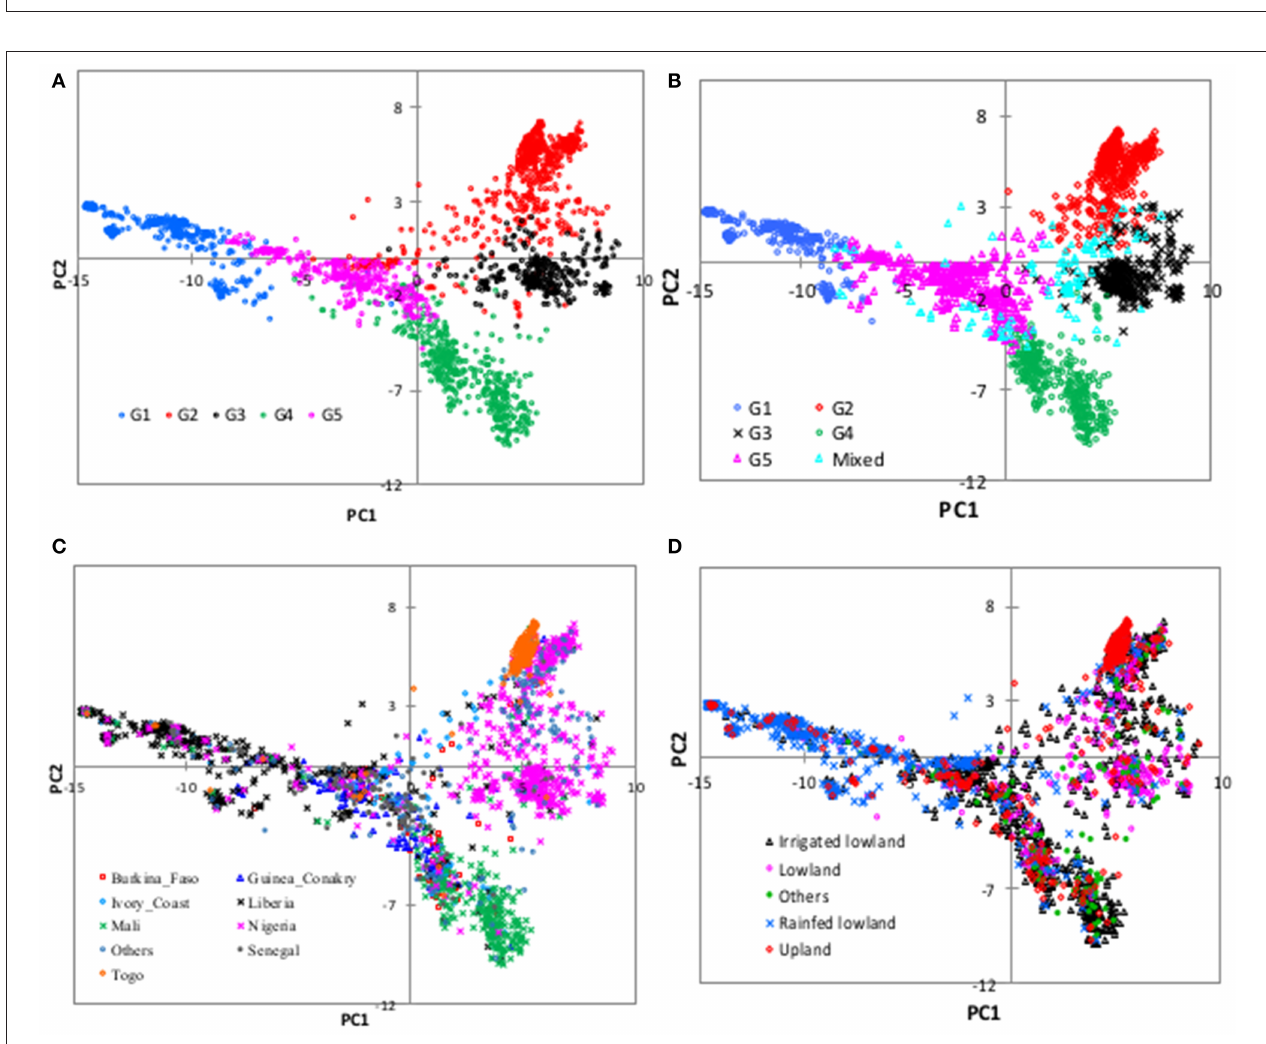
FIGURE 4 | Plots of PC1 (14.6% of variation) and PC2 (5.8%) from principal component analyses of 2,179 O. glaberrima accessions genotyped with 3,834 polymorphic SNPs. The plots are based on group membership from (A) cluster analysis, (B) STRUCTURE at K = 5, (C) country of origin, and (D) ecology. All countries with < 40 accessions were combined to “others.” In the ecology plot, “others” refers to accessions from floating, mangrove, deep and shallow forest swamp, and hydromorphic ecologies, each with smaller number of accessions. See Supplementary Table S1 for details.